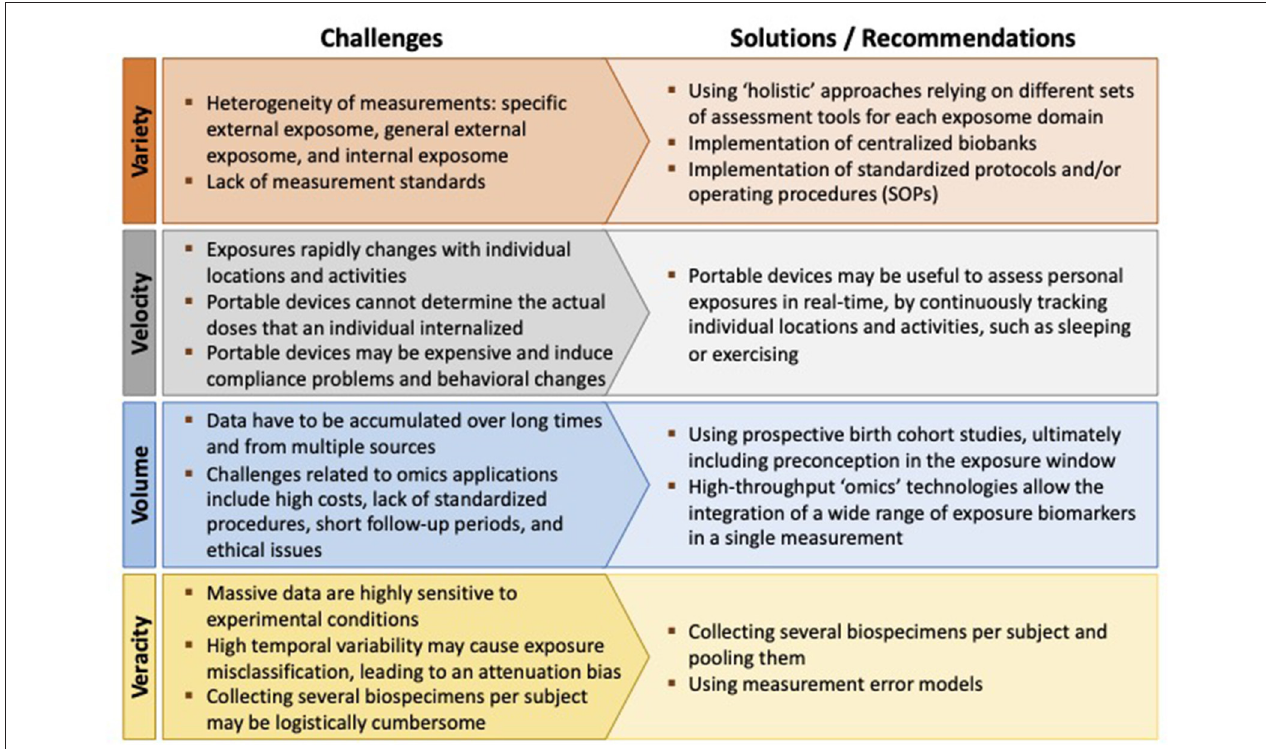
FIGURE 2 | The four challenging “Vs” associated with measurement platforms required for exposomic research.